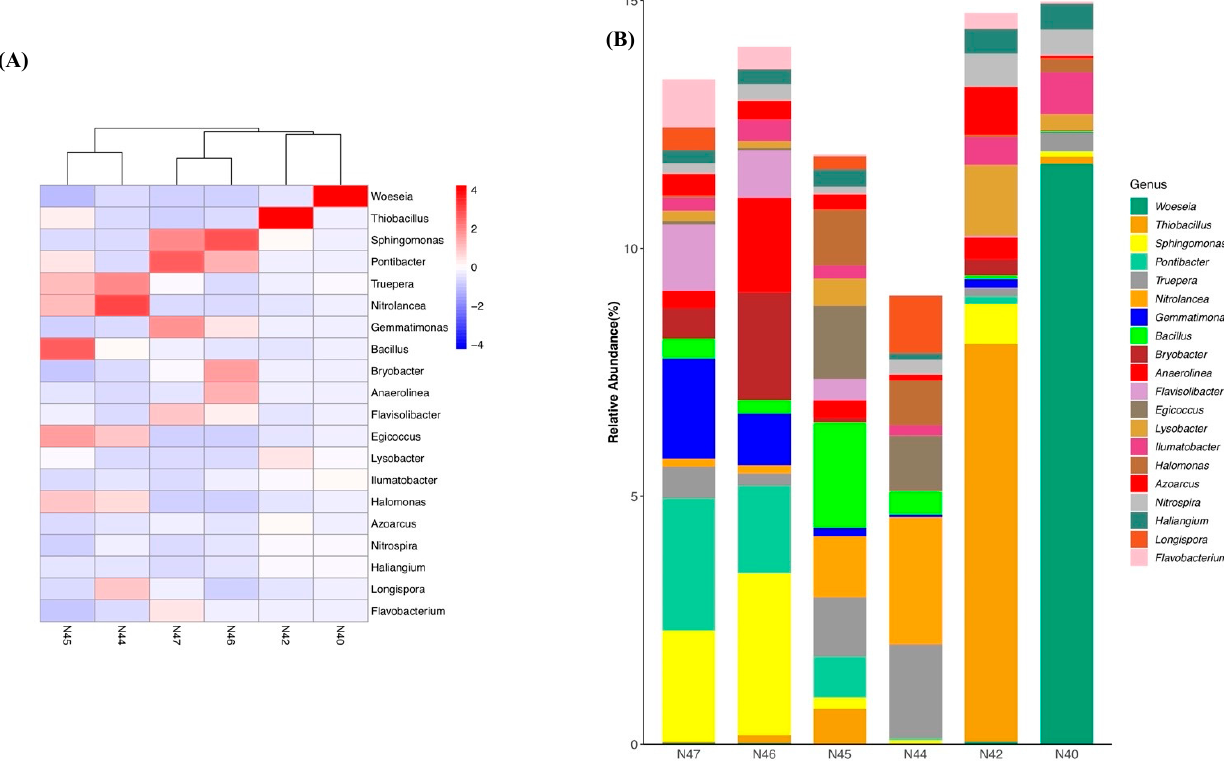
Figure 6. Bacterial community composition at genus level. ( A ) Heatmap clustering based on distribu- tion patterns of 20 most abundant genus-level OTU groups. The dendrogram showing the cluster dissimilarity between samples was constructed based on maximum distance. ( B ) Bar plots showing the relative abundances of bacterial genera in saline soil bacterial communities.